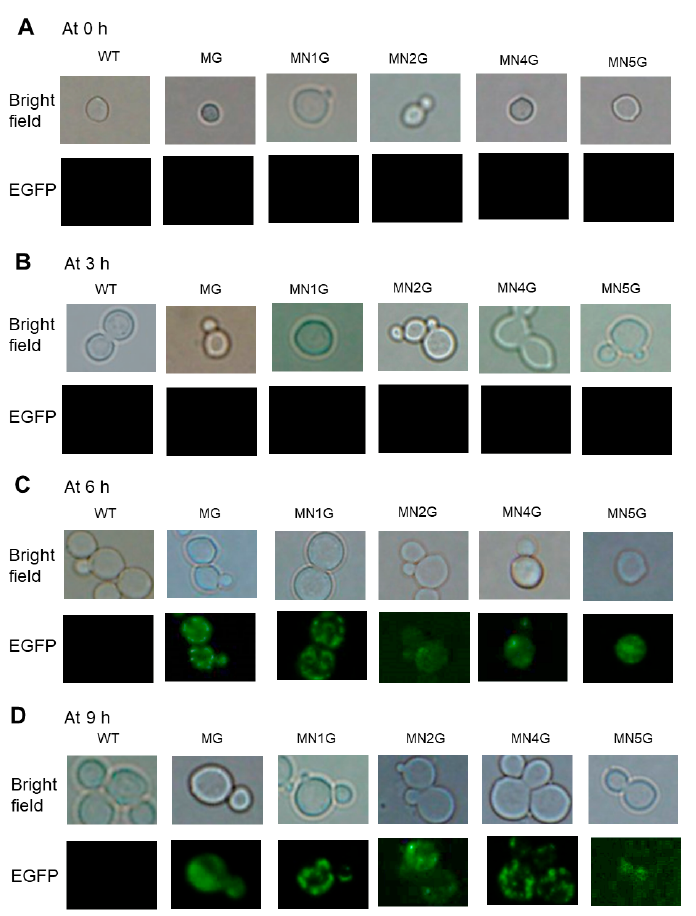
Figure 6. Time course of MT-Nad1-EGFP, MT-Nad2-EGFP, MT-Nad4-EGFP, and MT-Nad5-EGFP fusion proteins in yeast observed by fluorescence microscopy. The cells of yeast WT and transformants were induced with SC-U medium plus 2% galactose for 0–9 h at 30 °C to generate an EGFP signal. The images were taken at ( A ) 0 h, ( B ) 3 h, ( C ) 6 h, and ( D ) 9 h. Fluorescence microscopy was used to detect EGFP, which showed green fluorescence in the mitochondria. Bright-field microscopy was used to monitor the integrity of the cells.